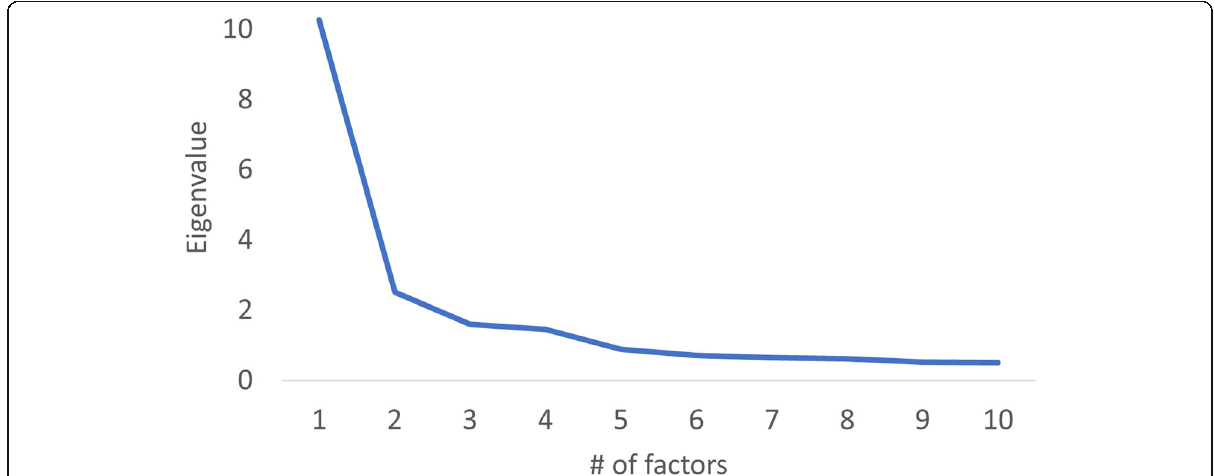
Fig. 2 Scree plot for determining number of factors in